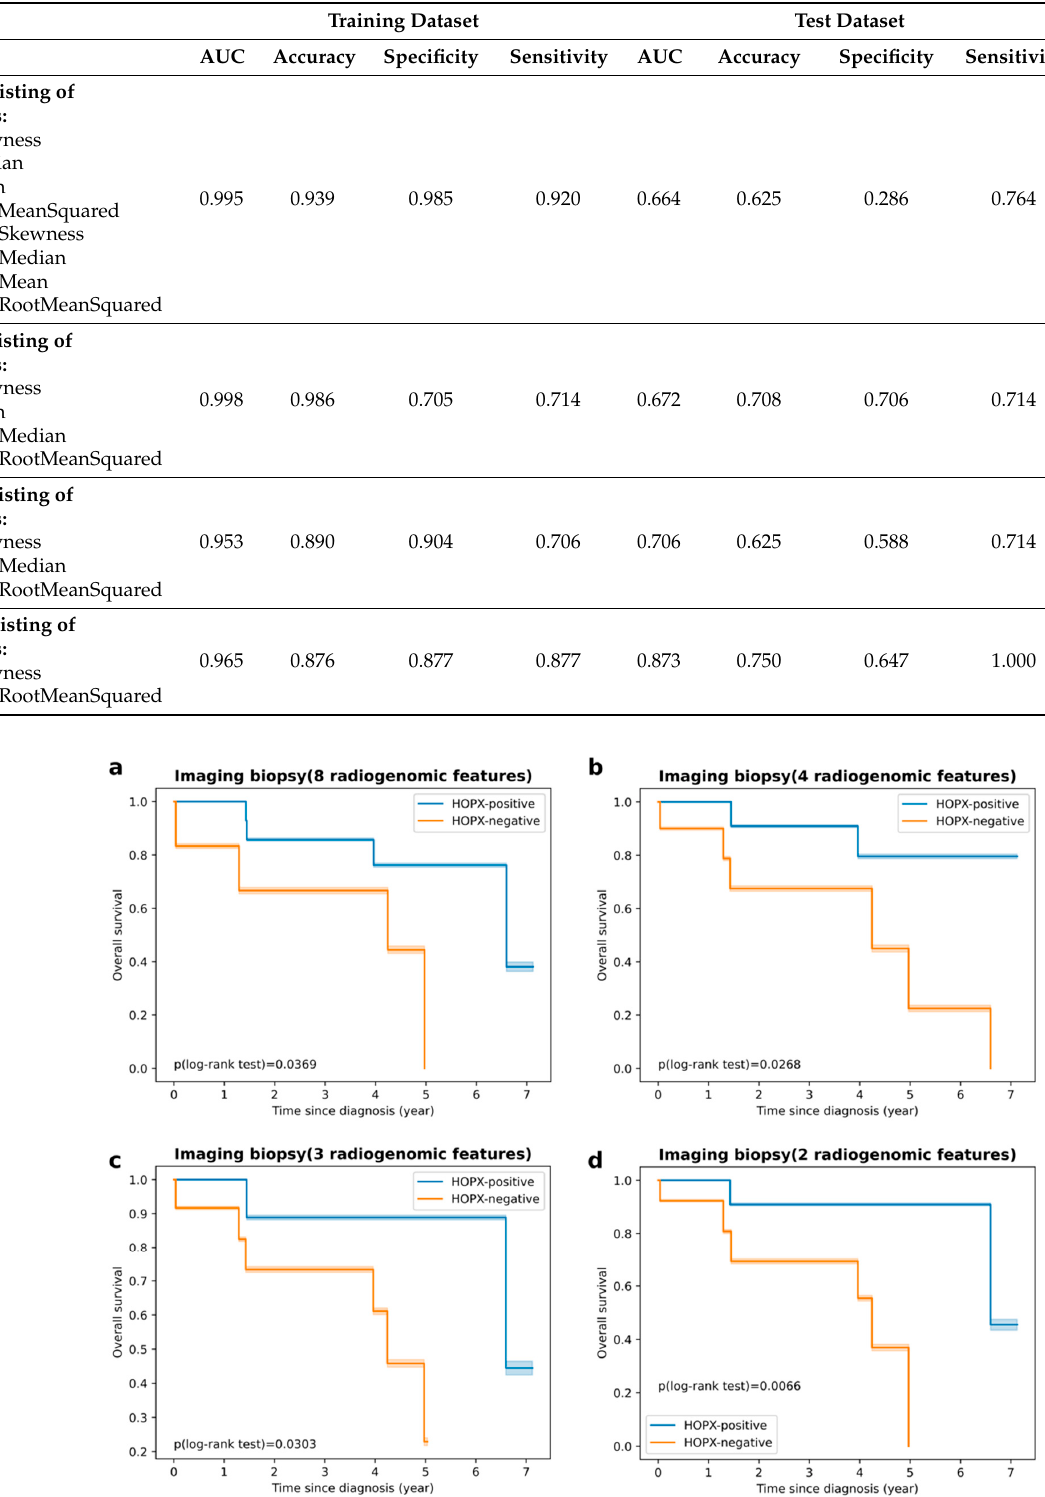
Table 2. Performances of the ensemble learning model—Stacking.